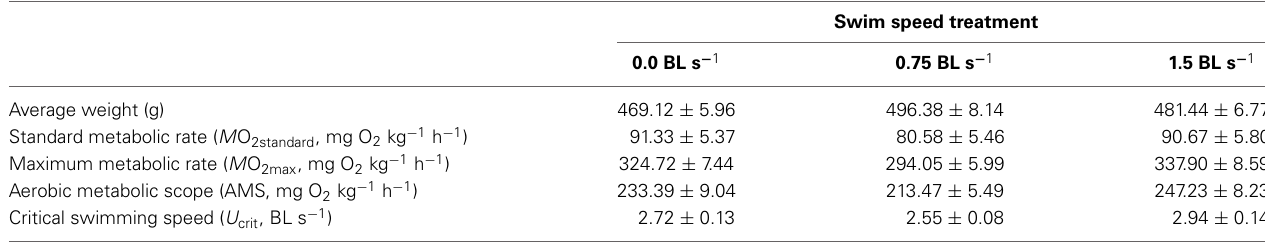
Table 2 | The average weight (g), standard metabolic rate ( M O 2standard ), maximum metabolic rate ( M O 2max ), and aerobic metabolic scope (AMS) of juvenile hapuku (measured as mg O 2 kg − 1 h − 1 ) as well the critical swimming speed ( U crit , BL s − 1 ) of juvenile hapuku raised for 6 weeks at either 0.0, 0.75, or 1.5 BL s − 1 and measured in a swim-flume respirometer.